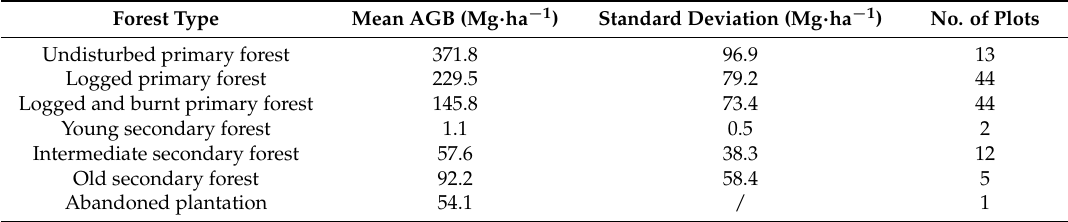
Table 1. AGB collection data in the municipality of Paragominas (see